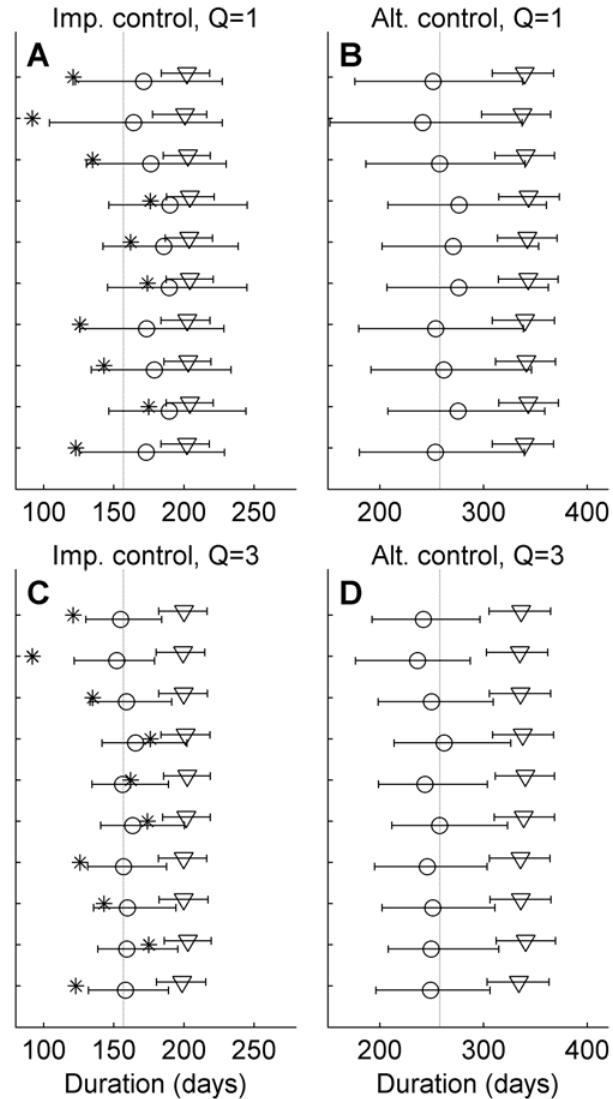
Fig 9. Analysis of synthetic data. Triangles and circles indicate the median posterior estimates of mean outbreak duration after analysis with the small and large discrepancy ensemble, respectively, under the implemented (Panels A and C) and alternative (Panels B and D) control action. Results are shown for ten realizations of synthetic data simulated with k1 = k2 = 0.9. The error bars indicate the 95% credibility interval, the dashed lines the true values and the star the individual realization analyzed (expected to often lie outside the predicted mean). Panels A and B show the results of single quantity analysis (only outbreak duration) and Panels C and D the corresponding results of analyses where number of infected farms and control culls are